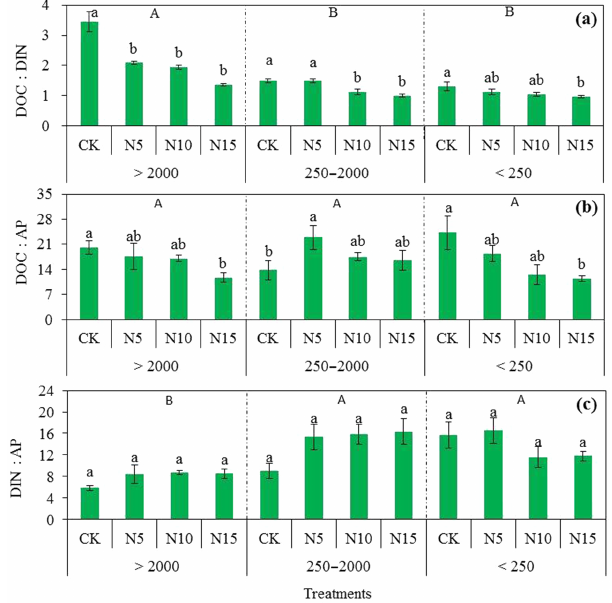
Figure 2. The ratio of (a) dissolved organic carbon to dissolved inorganic nitrogen (DOC:DIN), (b) DOC to available phosphorus (DOC:AP), and (c) DIN:AP as influenced by N addition (0 [CK], 5 [N 5 ], 10 [N 10 ], and 15 [N 15 ]gNm − 2 yr − 1 ) in soil aggregates. Data are represented as mean ± SE. Lowercase letters indicate sig- nificant differences between N treatments within a soil fraction. The capital letters at the top indicate significant differences between soil aggregate sizes across N